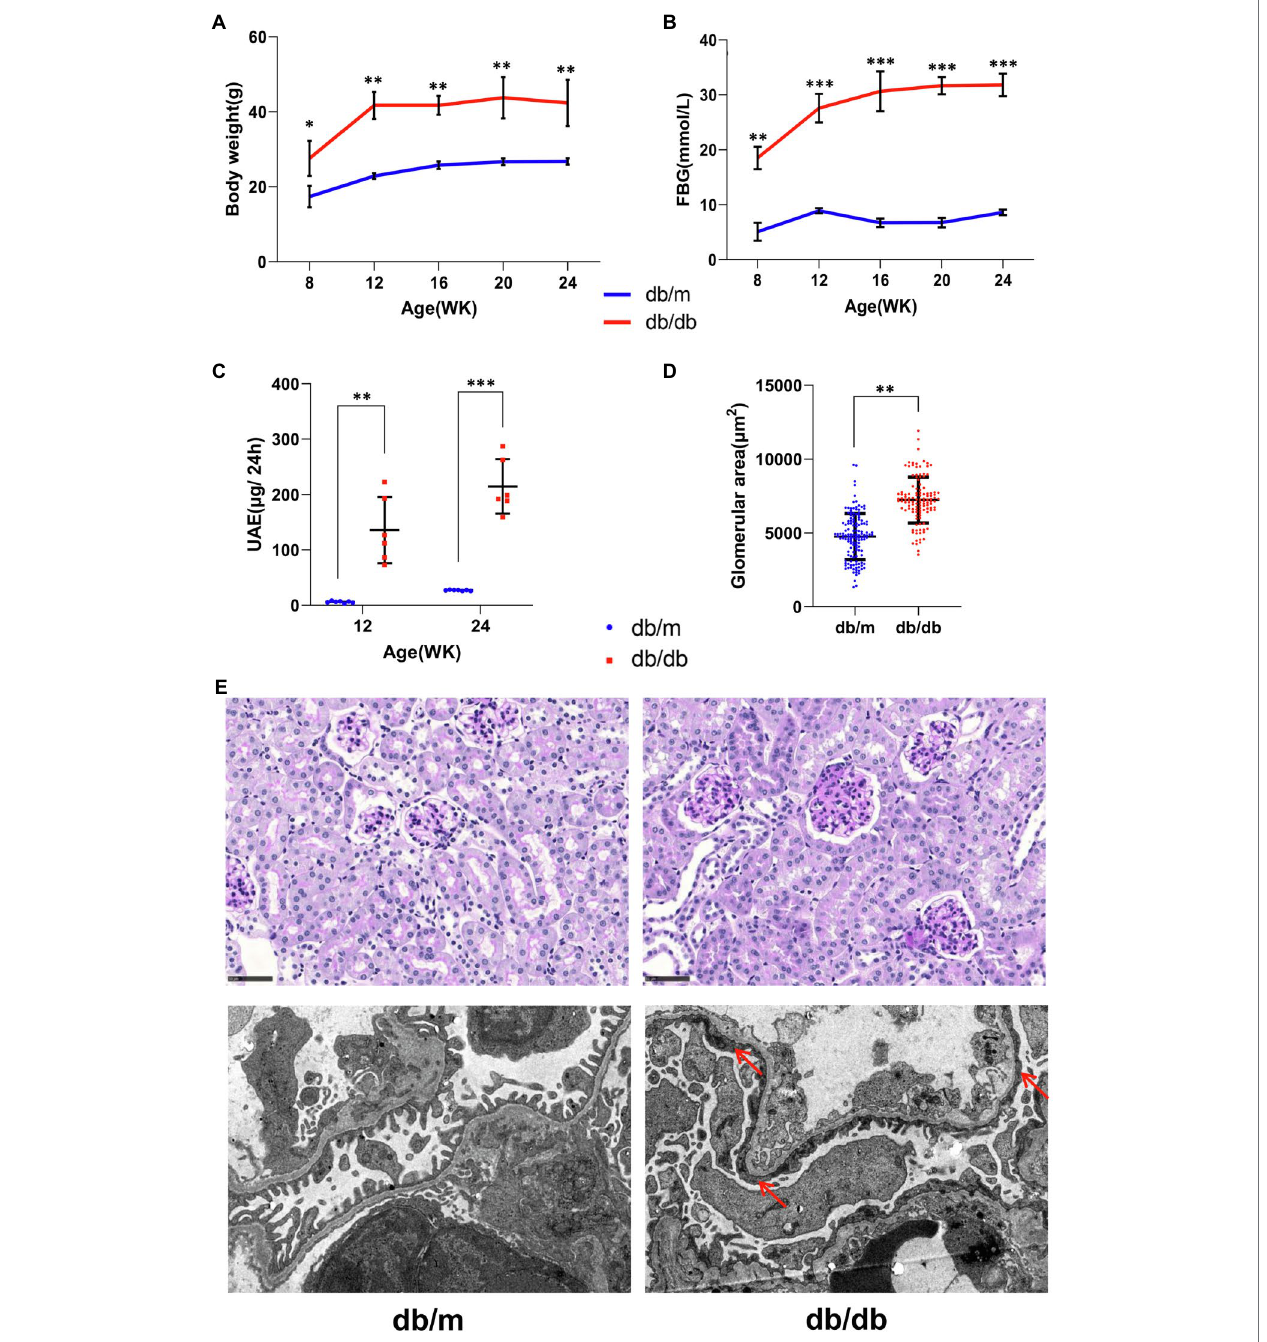
FIGURE 2 | Basic biochemical parameters and pathologies from db/m ( n = 7) and db/db ( n = 6) mice. (A) Body weight, (B) overnight fasting abdominal blood glucose (FBG), and (C) 24-h urinary albumin excretion (UAE) levels are shown. (D) The glomerular areas measured in pathological images were markedly increased in db/db mice (also see the periodic acid–Schiff staining images below). Data are presented as mean ± standard error (SE), * p < 0.05, ** p < 0.01, and *** p < 0.001 ( t -test). (E) Representative pathological images are shown. (Upper) Periodic acid–Schiff staining images, bar = 50 μ m. (Down) Electron microscopy images with a 4,200-fold magnification. The extensive fusion of foot processes (red arrows) in db/db mice was